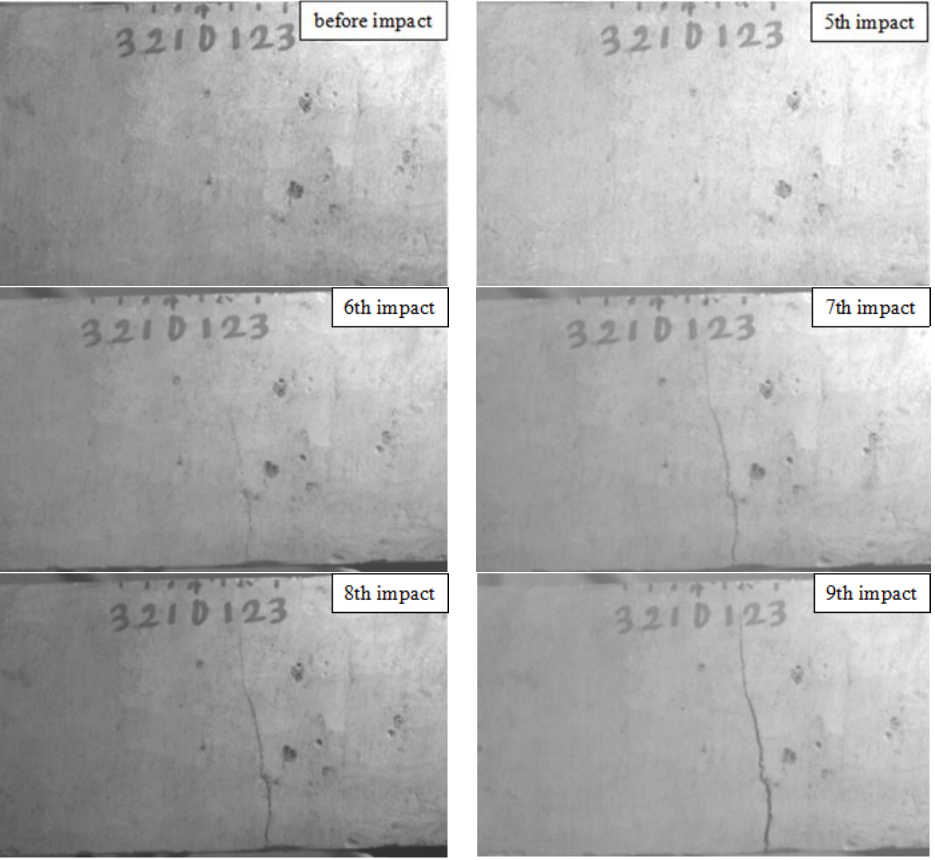
Figure 4. Photograph of the specimen’s surface before and after impacts.